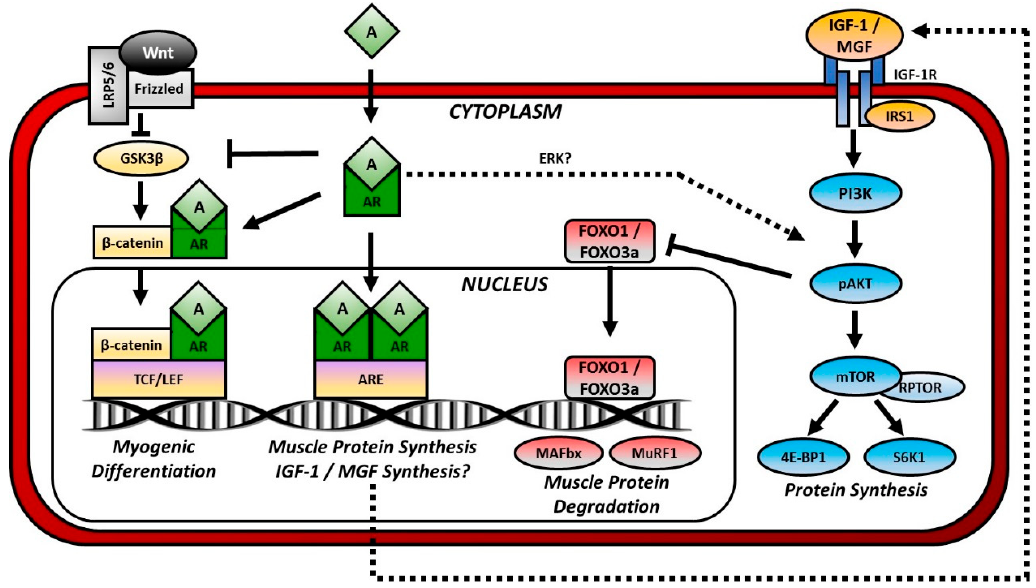
Figure 1. Androgen-mediated Anabolic and Anticatabolic Signaling Pathways in Muscle. Anabolic signaling: Androgens (A) pass through the plasma membrane and bind to cytosolic androgen receptors (AR). Dimerized and phosphorylated ARs pass through the nuclear membrane and bind to a region of the DNA termed the androgen response element (ARE), thereby initiating protein synthesis. Ligand-bound ARs may also enhance Wnt signaling as follows. Wnt binds to Frizzled and in turn disheveled (not shown). Disheveled inhibits the activity of glycogen synthase kinase-3 β (GSK3 β ), which phosphorylates β -catenin and marks it for degradation. When GSK3 β is inhibited, β -catenin accumulates and enters the nucleus where it binds to a region of the DNA termed the T-cell factor/lymphoid enhancer factor (TCF/LEF) that regulates genes involved in myogenic differentiation. Ligand-bound ARs enhance Wnt signaling by inhibiting GSK3 β and attaching to β -catenin for nuclear shuttling. Androgens may also indirectly stimulate protein synthesis by activating the phosphatidylinositol-3 kinase (PI3K)/Akt signaling through actions of Erk or by promoting synthesis of insulin-like growth factor (IGF)-1 or mechano growth factor (MGF). IGF-1 and MGF bind cell-surface IGF-1 receptors (IGF-1R) and activate PI3K/Akt signaling. Anticatabolic signaling: Activation of PI3K/Akt signaling inhibits the transcription factor forkhead box O (FOXO). FOXO1 and FOXO3a activate muscle atrophy F-box (MAFbx or atrogin-1) and muscle ring finger-1 (MuRF1), and E 3 ubiquitin ligases that prepare proteins for proteasome degradation.